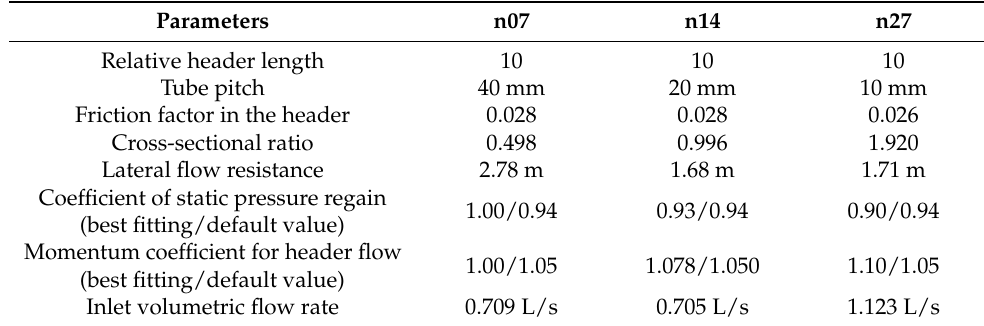
Table 5. Parameters of the investigated distributor configurations (n07, n14, and